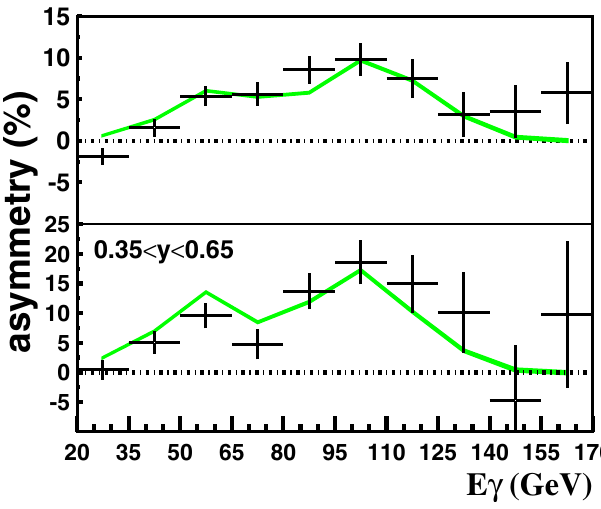
FIG. 15. (Color) Asymmetry to determine the (cid:2) the photon polarization with the Ge analyzer. The data at roll angles (cid:5)= 4 (cid:9) 5 (cid:5)= 4 are compared to 3 (cid:5)= 4 (cid:9) 7 (cid:5)= 4 without (top) and with (bottom) the quasisymmetrical pair